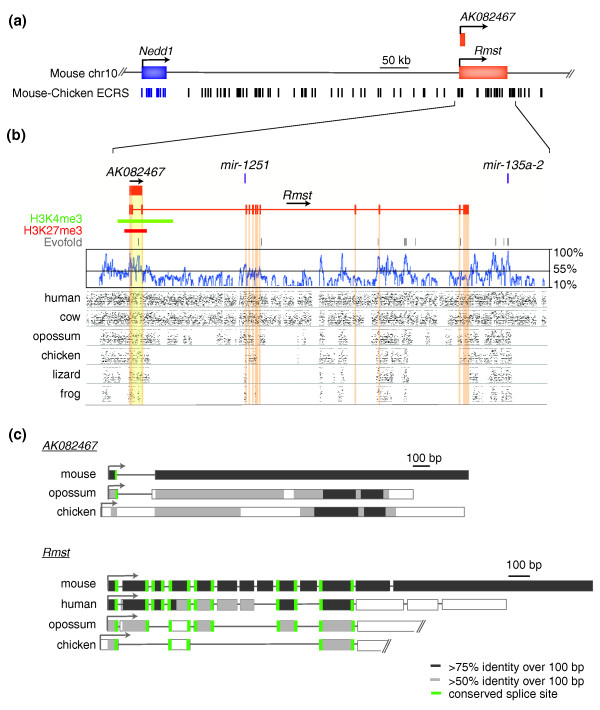
Evolutionary constraint of AK082467 and Rmst. (a) The genomic region of mouse chromosome 10 (chr 10) encompassing lncRNAs AK082467 (2.7 kb) and Rmst (2.7 kb) is depicted. Note the presence of the protein-coding gene Nedd1 (neural precursor expressed developmentally down-regulated protein 1) upstream of AK082467 and Rmst. (b) A more detailed representation of AK082467 and Rmst (exons highlighted in yellow and orange, respectively), microRNAs mir-1251 and mir-135a-2, and their immediate flanking regions. Below the gene structures are the positions of H3K4me3 (green) and H3K27me3 (red) chromatin marks detected in mouse brain (obtained from the UCSC Genome Browser) as well as similar tracks as those in Figure 2b. Note the detected homology with orthologous frog sequence in Rmst exons 1, 2, 4, and 11. (c) Conservation and relative sizes of AK082467 and Rmst orthologs in various species. Note the conserved splice sites (green bars) in mouse Rmst exons 1, 4, and 11 as well as the sequence conservation (relative to mouse sequence) in exons 1 and 11, but differences in total exon number among species. The 3' ends of opossum and chicken orthologs have not been experimentally verified. Other details are provided in the legend to Figure 2. ECR, evolutionarily conserved region.